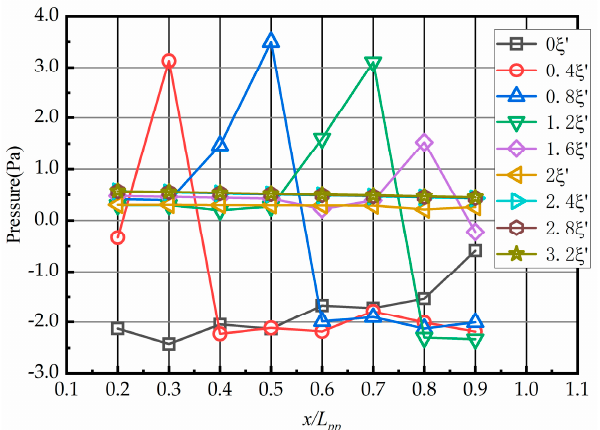
Figure 9. Hydrodynamic pressure variation along the hull at different values of ξ′ .